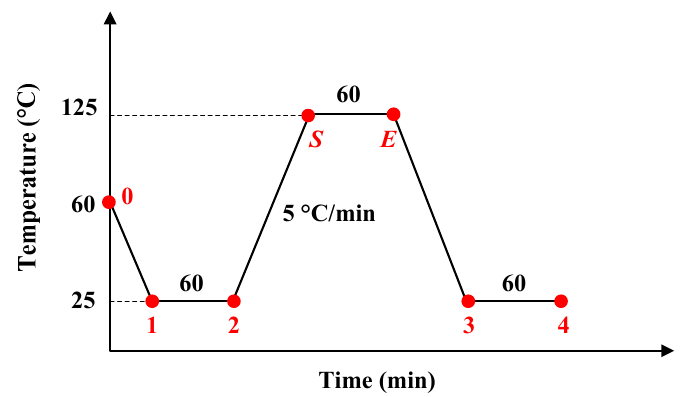
Figure 9. The first thermal cycle process at 125 °C.